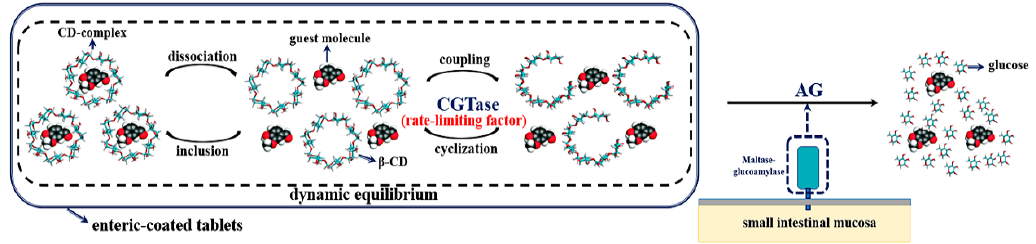
Figure 7. The schematic diagram of the CD-based controlled release system in the small intestine.